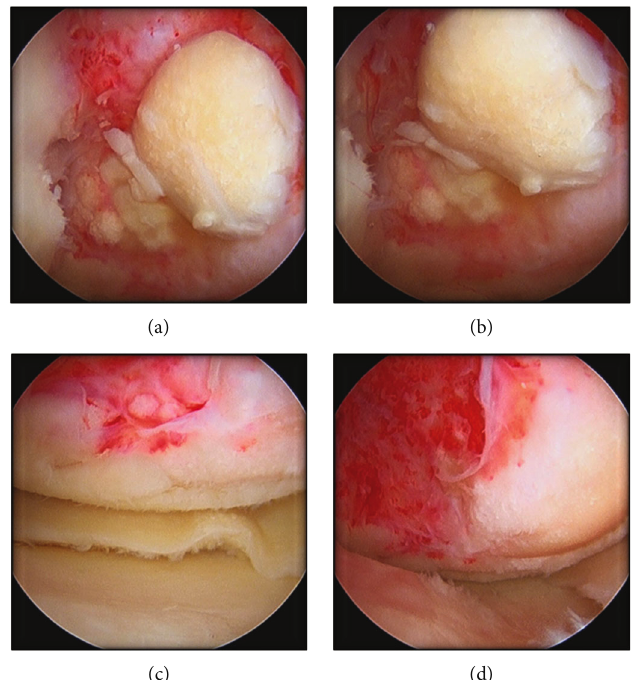
Figure 5: Arthroscopy. (a) Fragmentation medial OCD. (b) Irreparable fragment. (c) Medial posterior OCD. (d) Bone defect/medial wear.